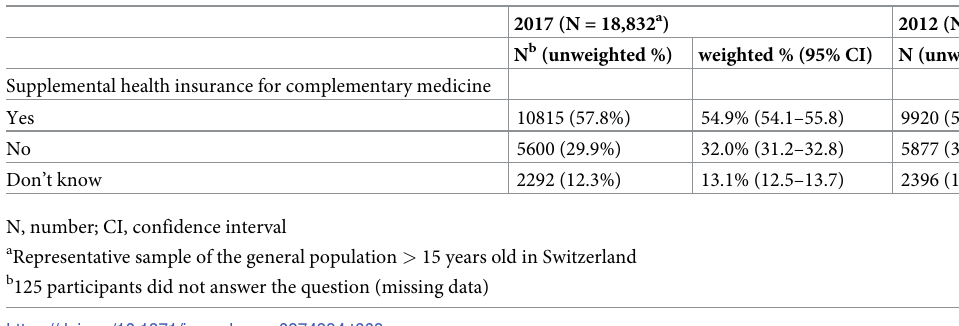
Table 3. Supplemental health insurance for complementary medicine (Swiss Health Survey 2012 and 2017).